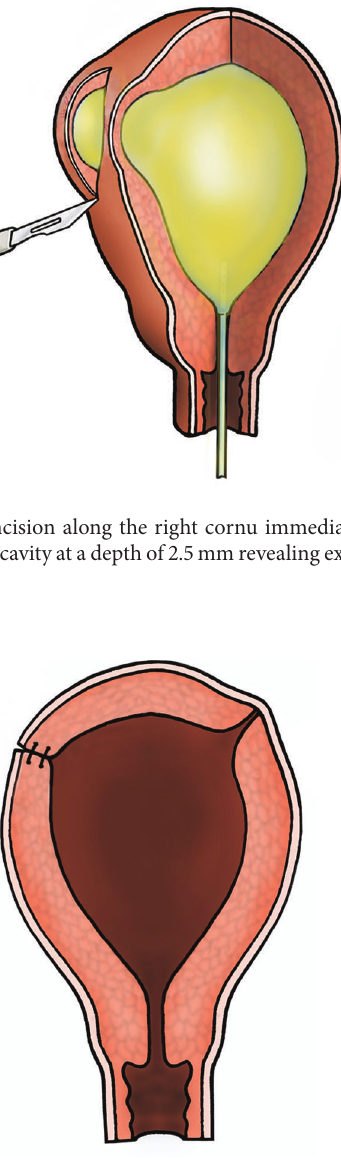
Figure 3: The cornu was gradually reconstructed by 2-3 layers of continuous suturing with vicryl (polyglactin 910) sutures. The cornual musculature was artificially thickened by bringing the laterally retracted deep myometrial fibres from around the cornua onto and above the incision site.